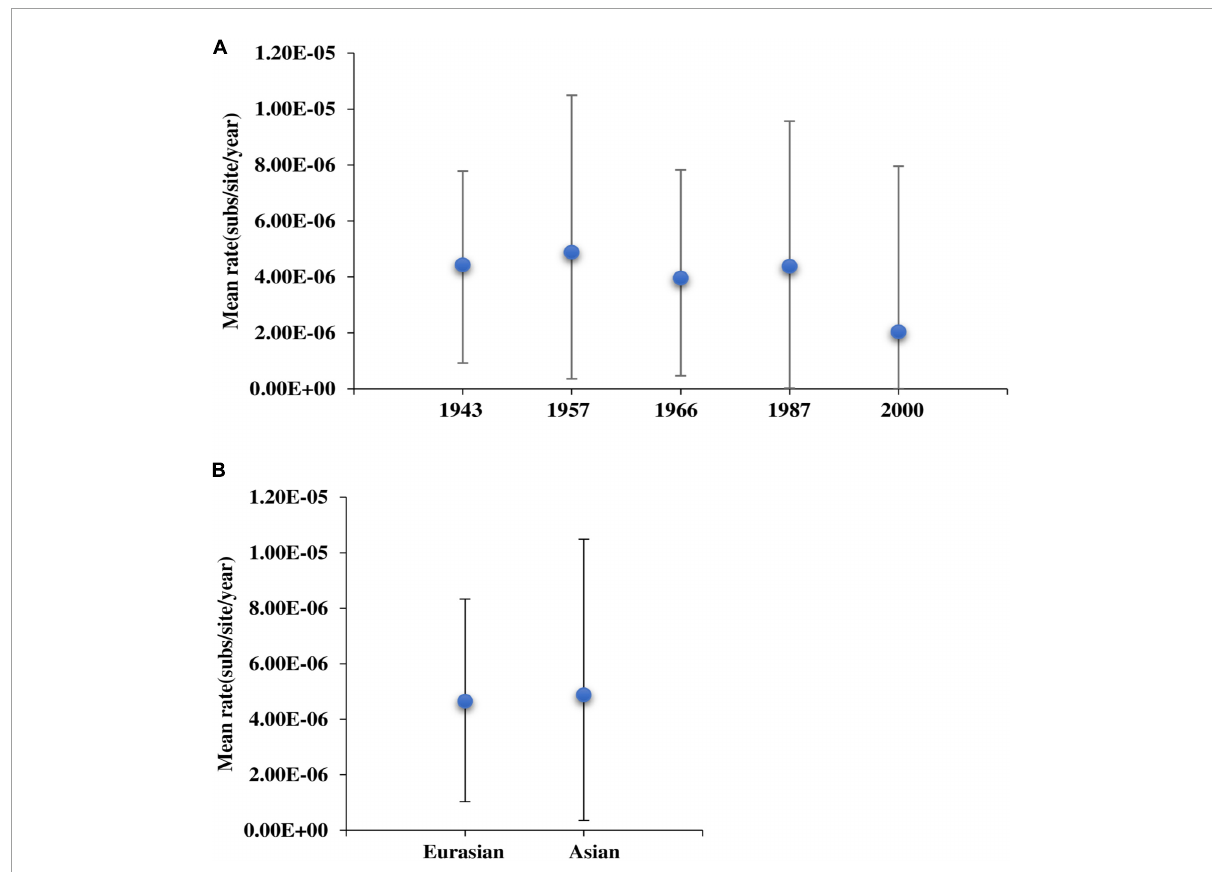
FIGURE3 The evolutionary rate of Marek’s disease virus (MDV) strains. (A) Analyses of the evolutionary rates of MDV strains. (B) Comparison of the evolutionary rate between Eurasian and Asian